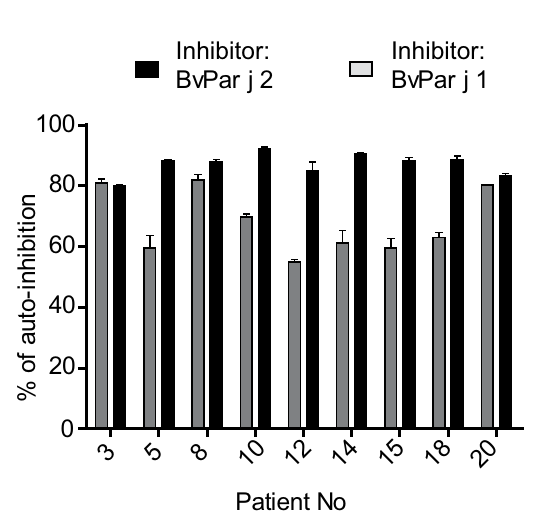
Figure 6. IgE cross-reactivity of Par j 1 and Par j 2 studied by IgE inhibition ELISA. Shown are the percentages of inhibition of IgE binding to BvPar j 1 and BvPar j 2 achieved by pre-incubating sera from patients (x-axis) with the other allergen (Inhibitors: BvPar j 1 grey column; BvPar j 2 black column). Results are expressed as percentages of auto-inhibition + / − SD